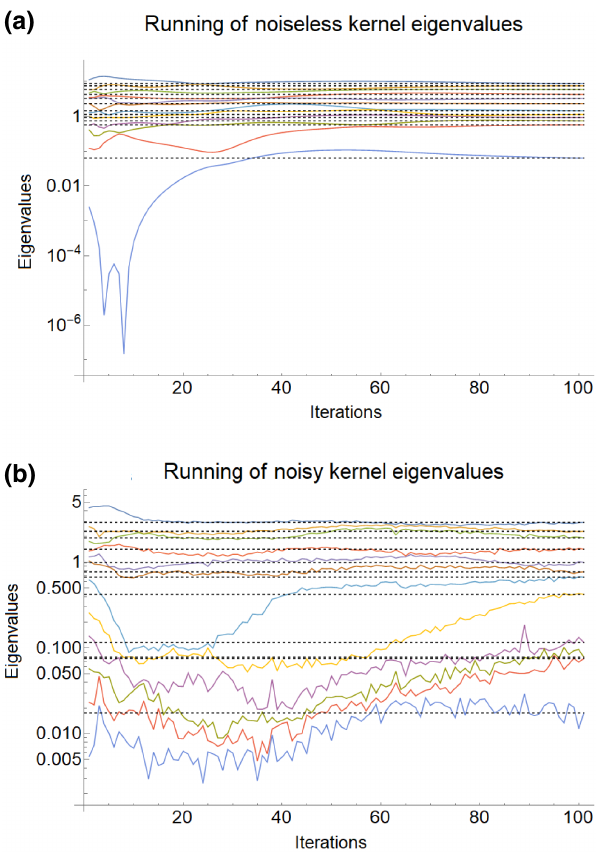
FIG. 6. Kernel eigenvalues during the gradient-descent dynamics. Up: noiseless simulation. Down: noisy simulation including a model of device errors. The solid curves are 12 nonzero eigenvalues of the QNTK, while the dashed lines are theoretical predictions of the frozen QNTK at the late